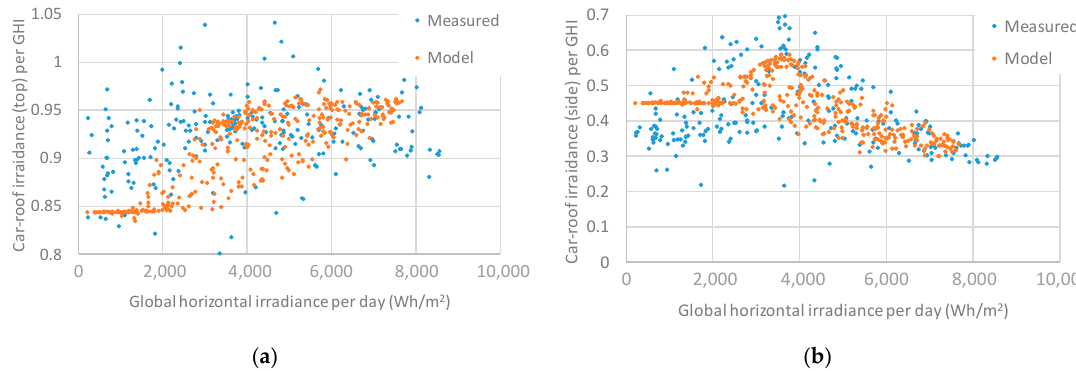
Figure 16. Daily-based comparison between the measured solar irradiance around the car (blue dots) and modeled (typical year from the METPV-11 solar database) solar irradiance on the car (orange dots): ( a ) car roof irradiance; ( b ) car side irradiance.